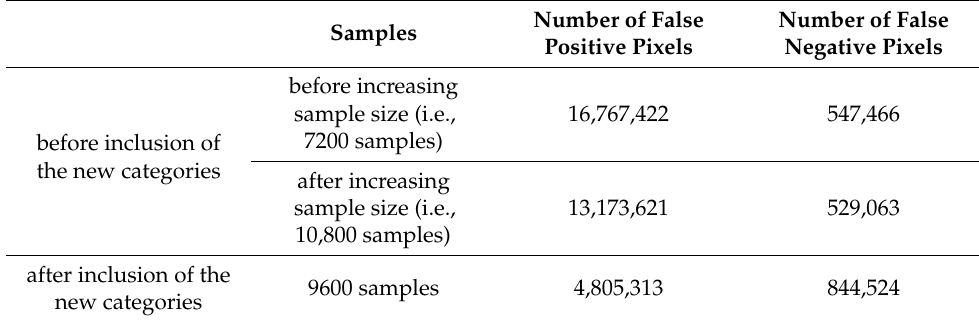
Table 7. Comparison of the number of false positive pixels and false negative pixels before and after increasing the training dataset size under the standard classification scheme (i.e., before inclusion of the new categories). The corresponding result after inclusion of the new categories (i.e., under the new classification scheme) is also provided for comparison. Number of False Number of False Samples Positive Pixels Negative